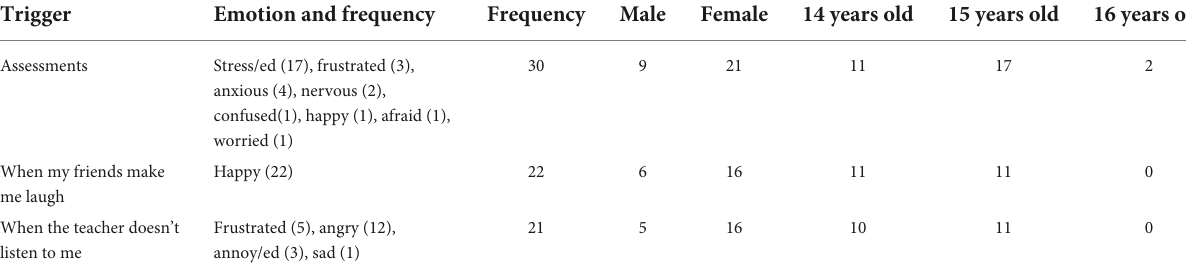
TABLE 2 Emotion